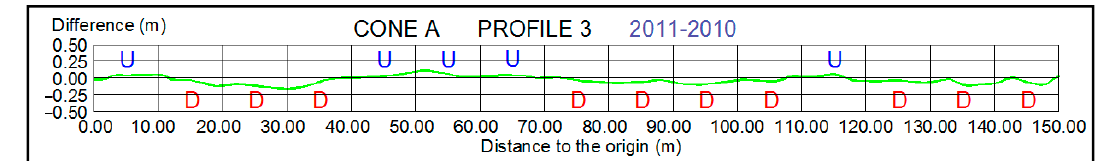
Figure 5. Thickening (U) and thinning (D) in the comparison between two consecutive years (2011– 2010) of profile 3 of cone A.